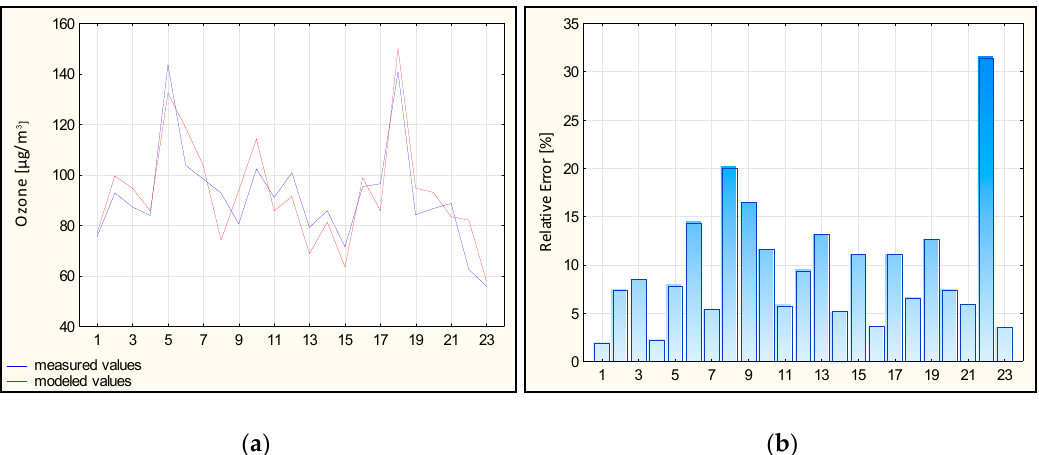
Figure 2. Results of modeling the daily maximum surface ozone concentration for validation subset (Belsk station). ( a ) Measured vs. modeled surface ozone concentration values. ( b ) Relative error of forecasted ozone values. For both graphs: x -axis represents days from April to September 2015 that were randomly selected for the validation subset.